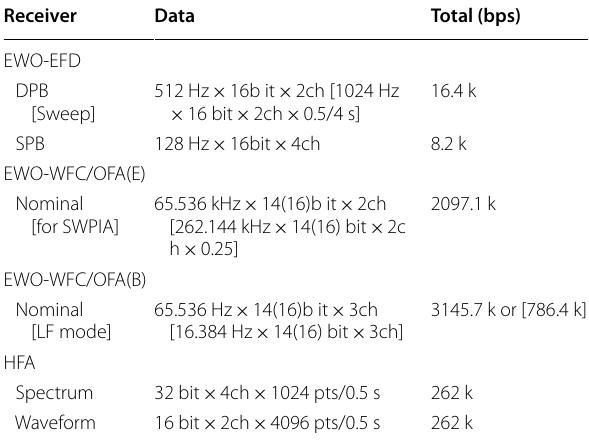
Table 3 Raw data produced in the PWE